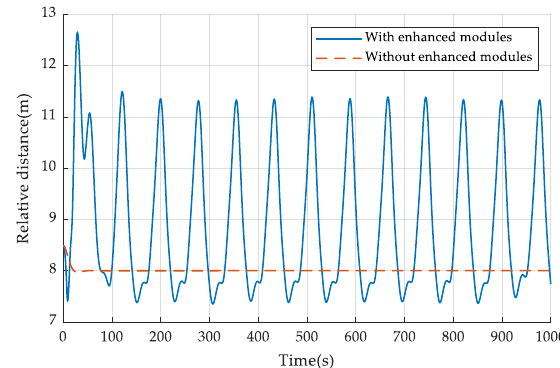
Figure 20. Relative distance curve.